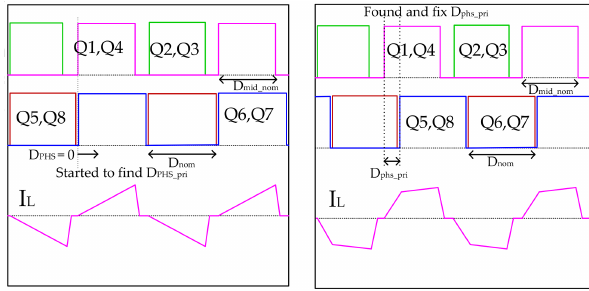
Figure 8. PWM signals plot at phase D soft-start